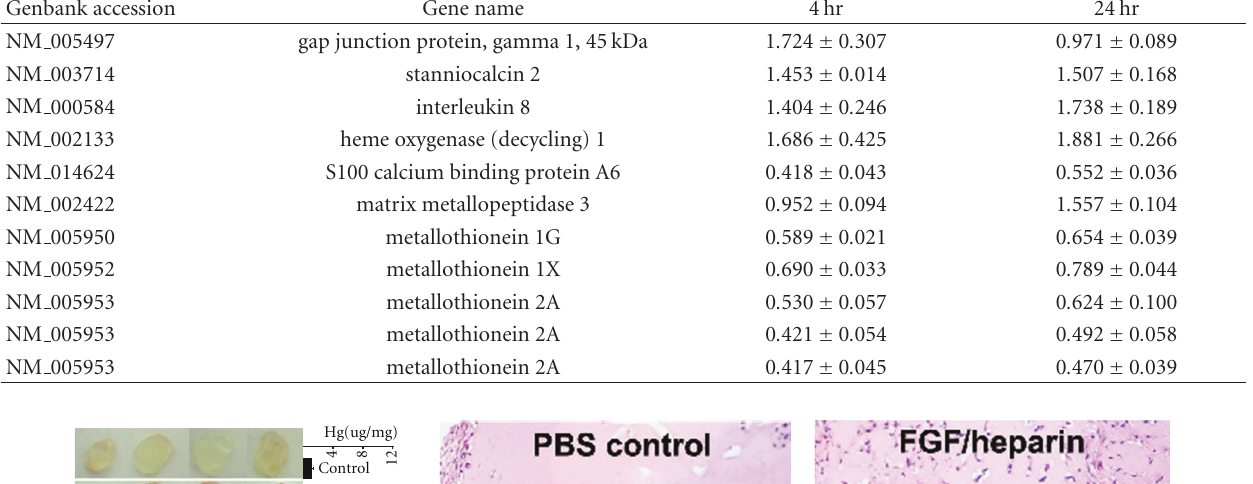
Table 1: Representative of changed genes upon S100A8 treatment.